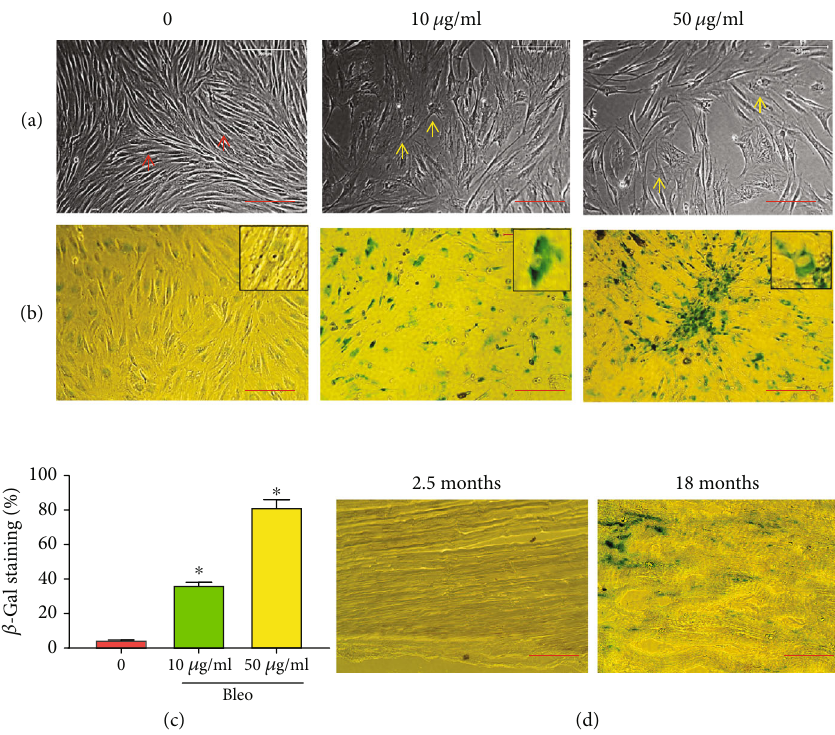
Figure 1: Bleomycin induces PTSC senescence in a dose-dependent manner. (a) Rat PTSCs were treated without or with bleomycin (Bleo) for 5 days. (b) PTSCs were stained for senescence-associated β -galactosidase ( β -gal) activity. As seen, at 10 and 50 μ g/ml, the senescent cells look fl attened and enlarged (a, yellow arrows) compared to control cells, which are elongated (a, red arrows). Scale bar = 200 μ m . (c) Semiquanti fi cation shows a marked increase in the number of β -gal-positive cells in a bleomycin-dose dependent manner. Results are expressed as mean ± SD , n = 3 . ∗ p < 0 : 01 compared to the control group. (d) Tendon tissues obtained from 2.5 month-old and 18 month- old rats were stained for the β -gal activity. It is evident that the young tendon is well organized without staining of β -gal; in contrast, aged tendon is disorganized and stained with β